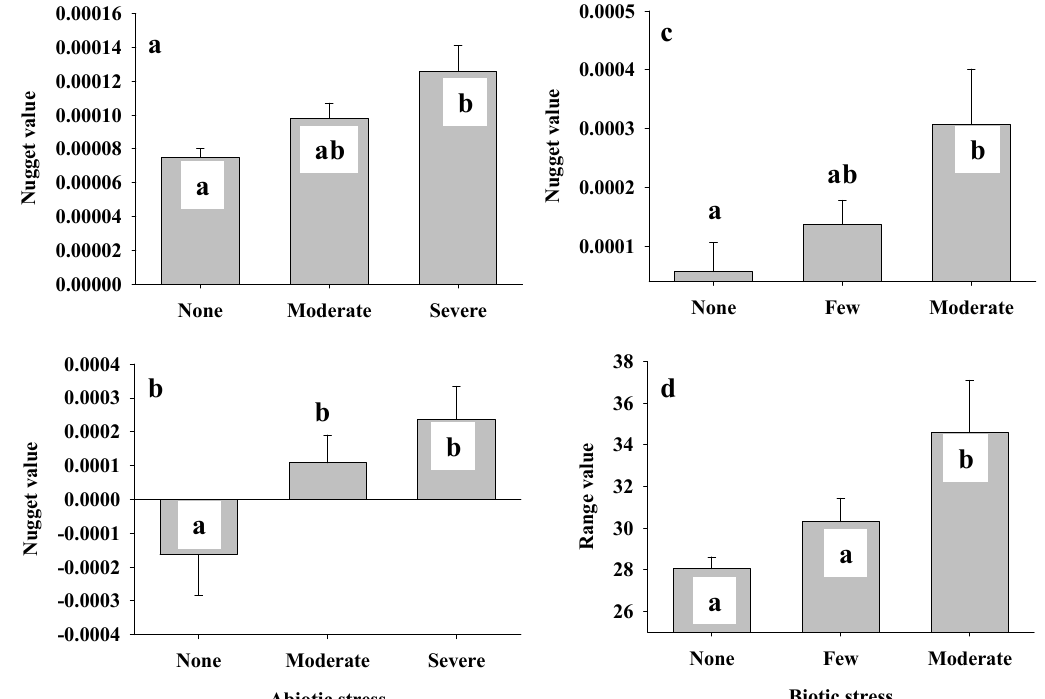
Figure 4. Nugget values at 683 nm ( a ) and 775 ( b ) in response to abiotic stress, and nugget values at 731 nm ( c ) and range values at 715 nm ( d ) in response to biotic stress. Different letters denote statistical difference at the